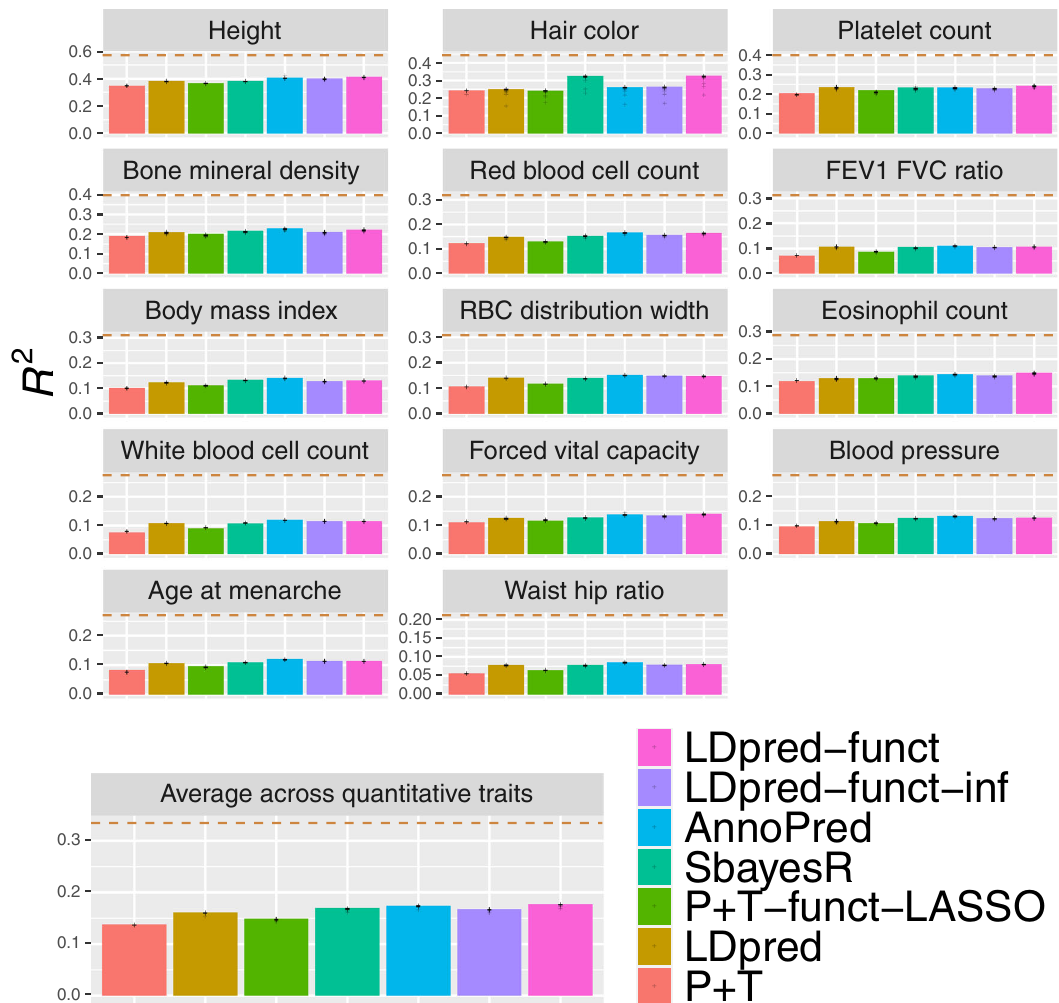
Fig. 2 Accuracy of 7 polygenic prediction methods across 14 UK Biobank quantitative traits. We report results for P + T, LDpred, SBayesR, P + T-funct- LASSO, AnnoPred, LDpred-funct-inf and LDpred-funct. Dashed lines denote estimates of SNP-heritability. Numerical results are reported in Supplementary Table 14. Abbreviations: Red Blood Cell Distribution Width (RBD distribution width), forced expiratory volume in one second (FEV1), and forced vital capacity (FVC). Data points represent the prediction accuracy values obtained via block-jacknife over 200 genomic blocks. Source data are provided as a Source Data fi